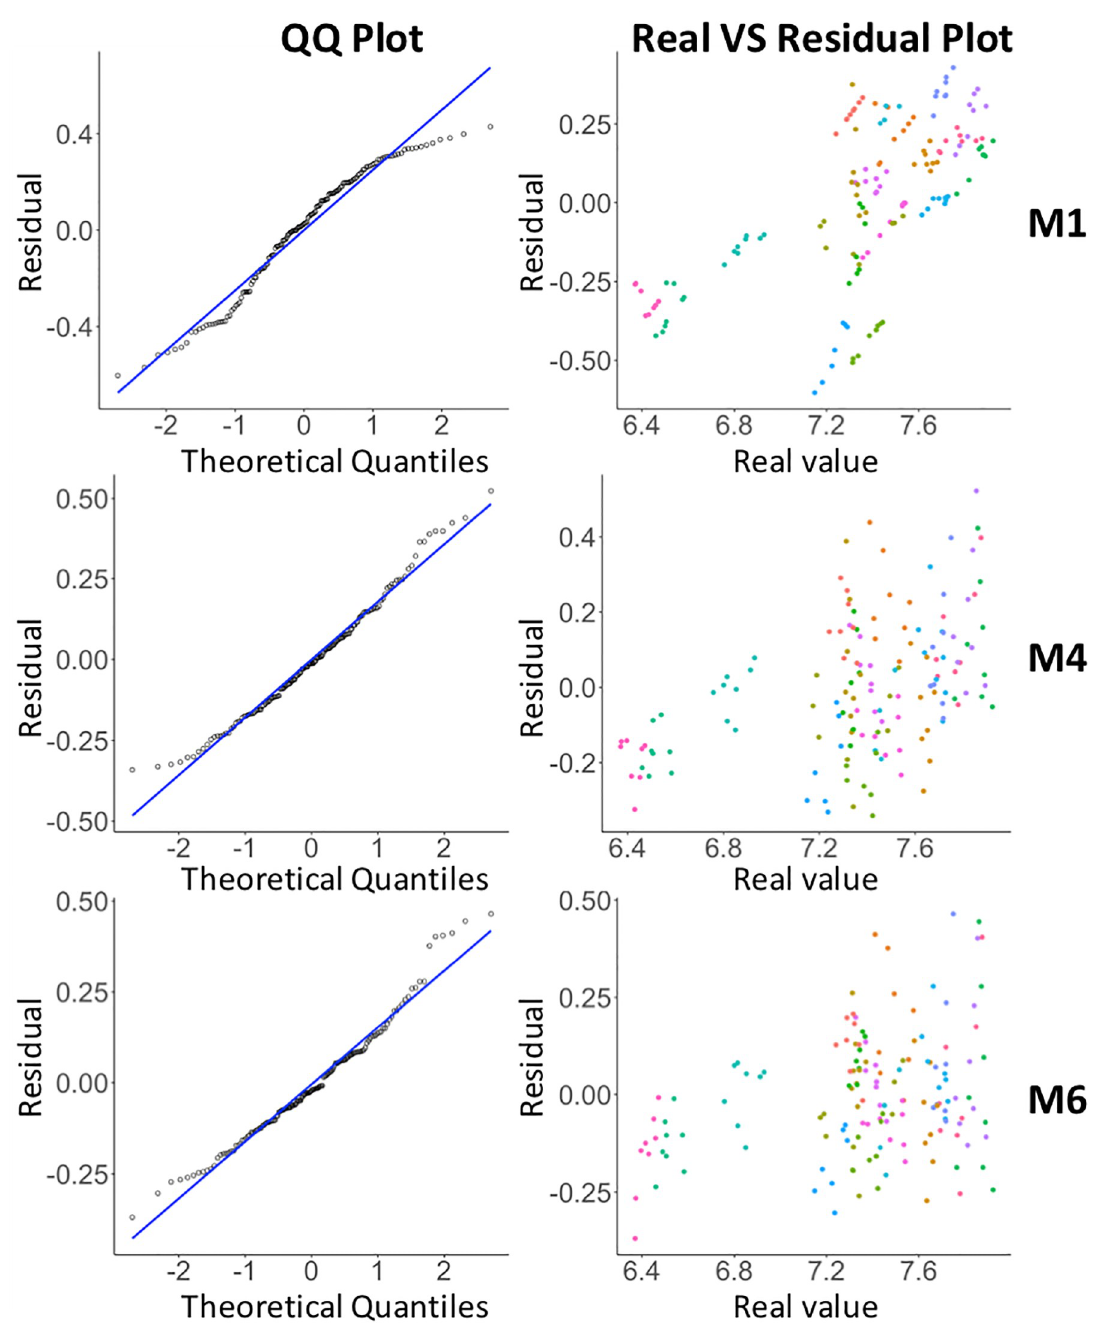
Fig 20. Residuals of fitting models: Comparison using Q-Q plots (left) and real vs. residual (right) for different models.